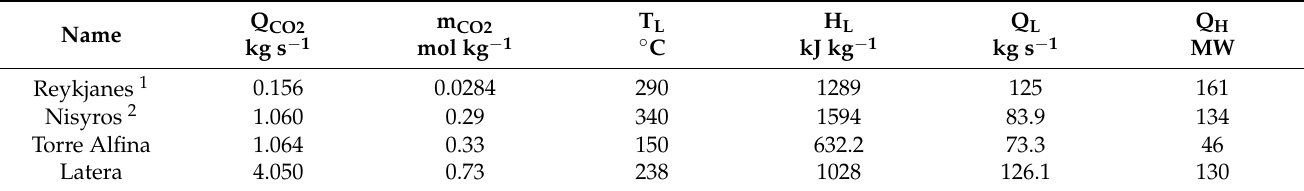
Table 2. Thermal energy associated with the convection of geothermal fluids. The cases were selected based on the availability of T L and m CO2 of the original geothermal